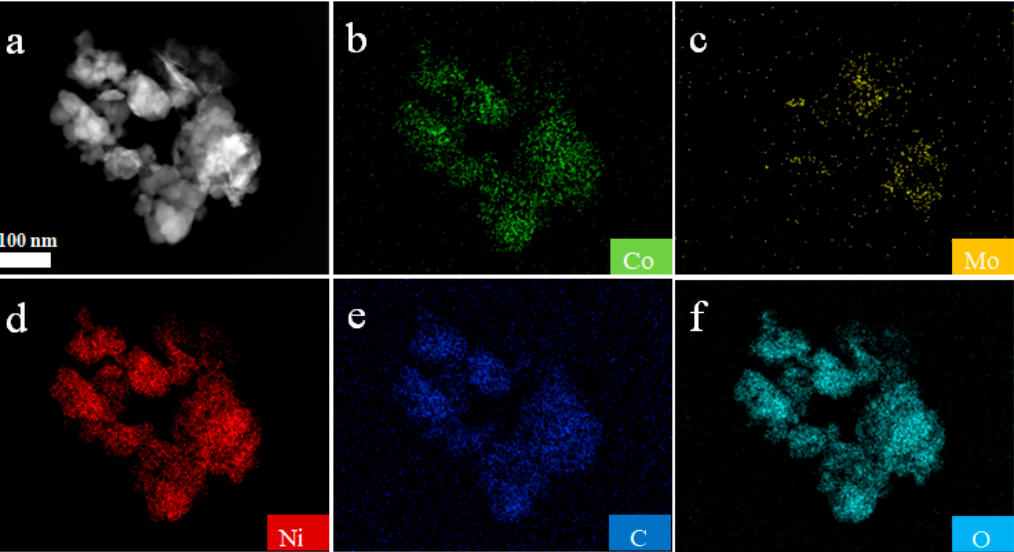
Figure 6. The elementary mapping of NiMo-LDH@NiCo-MOF, ( a – f ) shows that the product is composed of Co, Ni, Mo, C, O, and other elements, and each element is evenly distributed.